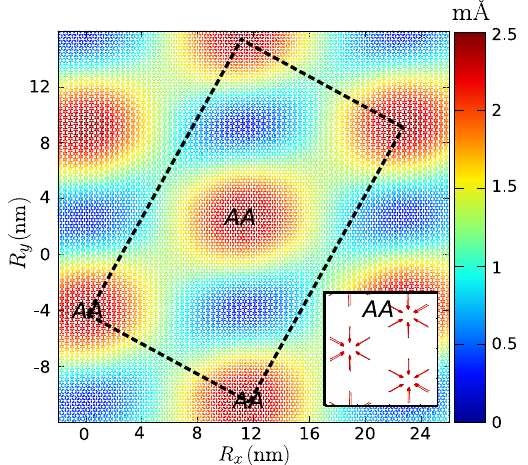
FIG. 8. Atomic displacements on one of the two layers corresponding to one of the moir´e modes at M marked by a green arrow in Fig. 5. The direction of displacement is repre- sented by a small arrow centered at each atomic position, while its modulus is encoded in colors. The mean deformation is 1.8 mÅ and leads to the DOS in Fig. 9. The inset shows an enlargement of the AA region close to the origin. The rectangular unit cell, now containing twice the number of atoms, is highlighted by a black dashed line. in such a Peierls state, even if the displacement is a tiny fraction of the equilibrium C – C distance. We note here that the zone boundary phonons are less effective in opening gaps at nonzero integer fillings than the zone center phonons are at the charge neutrality point. The reason is that away from charge neutrality the Jahn-Teller effect alone is no longer sufficient; one needs to invoke zone